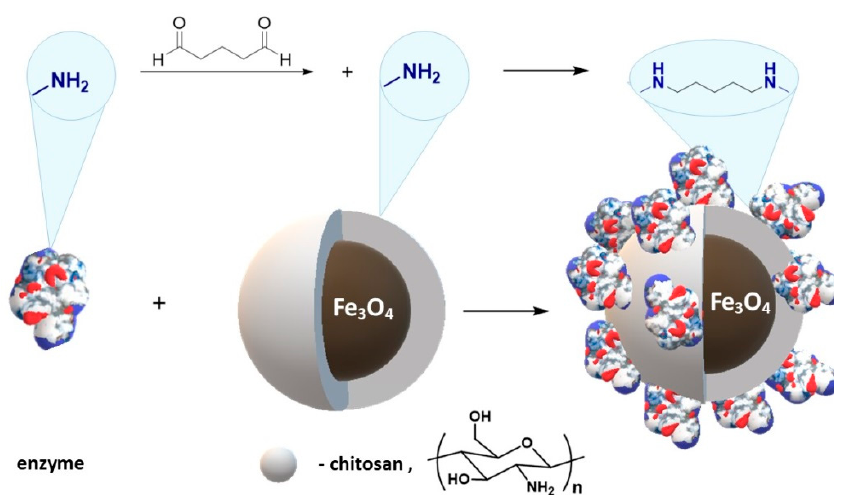
Figure 17. Enzyme immobilization on chitosan-coated magnetite nanoparticles with glutaraldehyde as a linker.